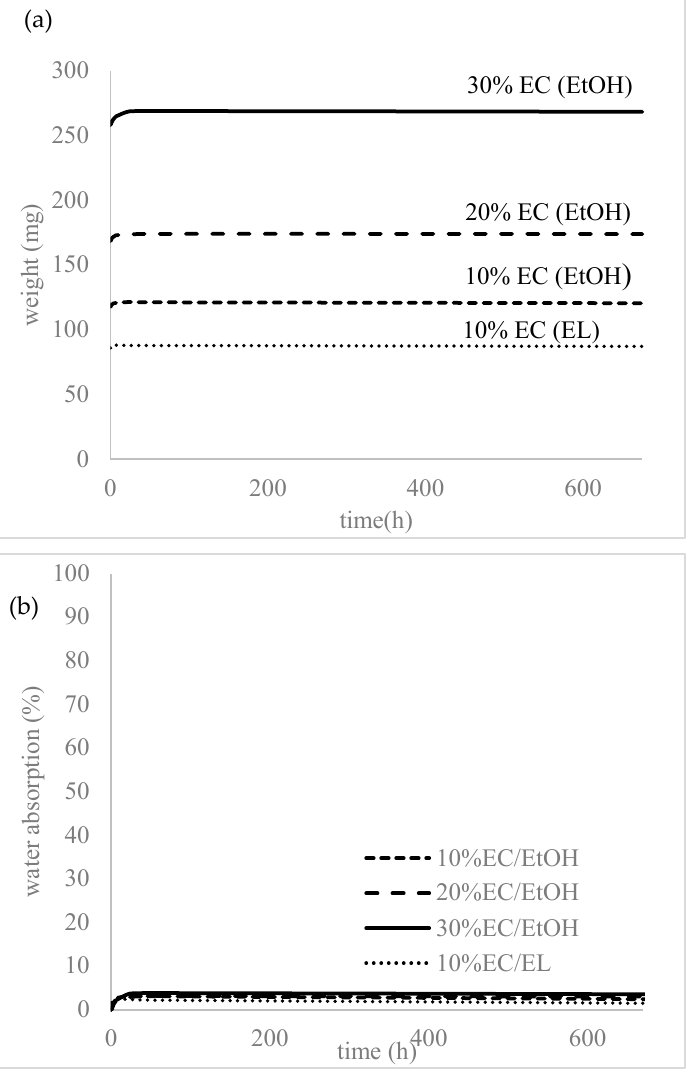
Figure 4. (a ) Degradation and ( b ) water absorption of the prepared samples. Figure 4. ( a ) Degradation and ( b ) water absorption of the prepared